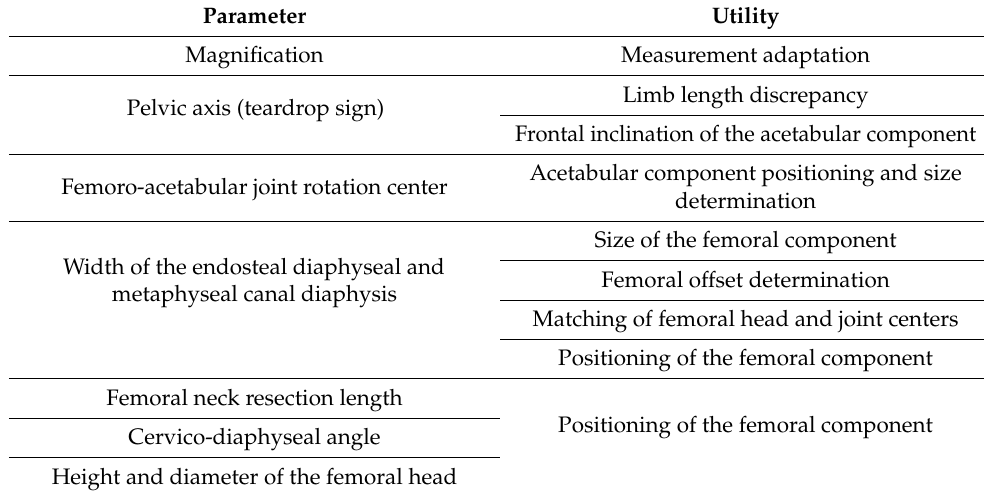
Table 1. Measurement to be made on preoperative radiographs for hip arthroplasty